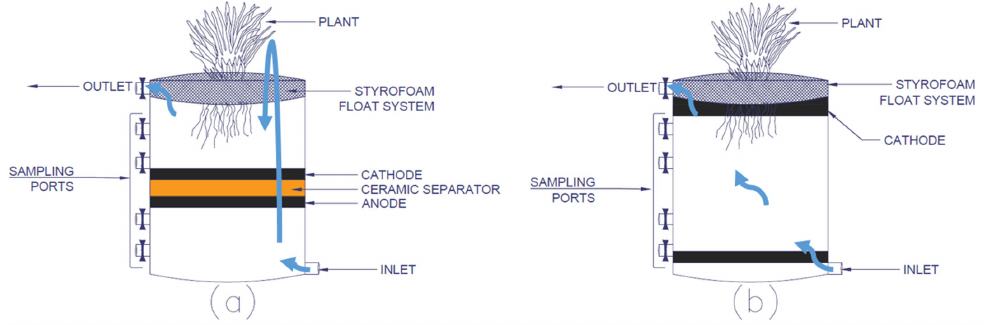
Figure 4. Hydroponic CW-MFC system ( a ) with ceramic separator and ( b ) without a ceramic separator ( adapted from Khuman et al. (2020 ) [60]).